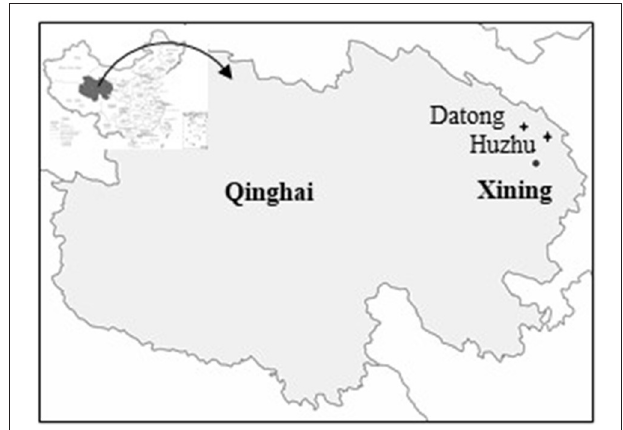
FIGURE 1 | A map showing sampling location in Qinghai of